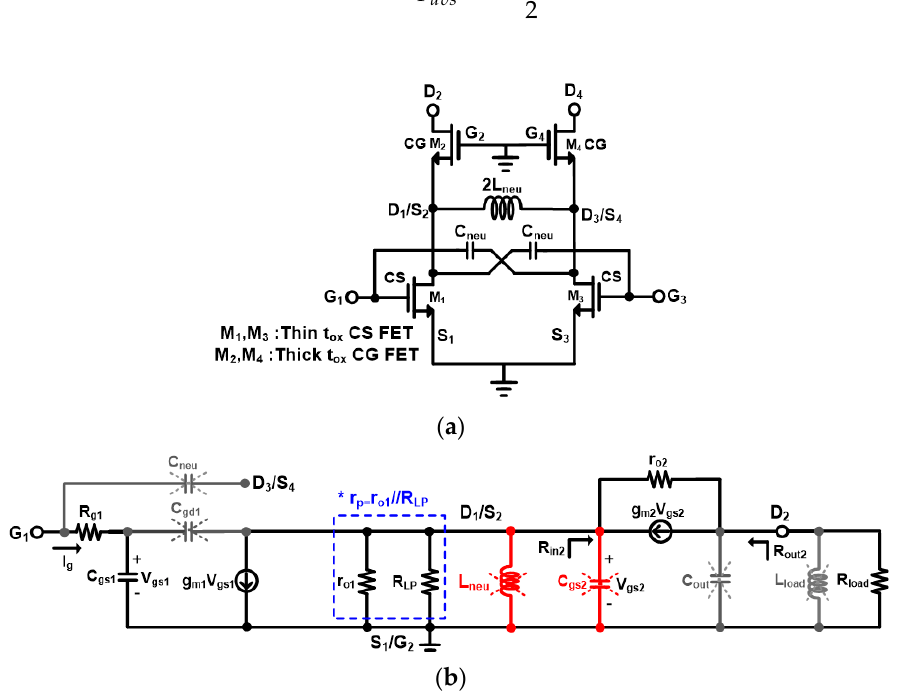
Figure 1. Hetero-stacked cascode power amplifier with a shunt inductor neutralization. The resistance R LP is a parallel equivalent resistance of the inductor L neu at the neutralizing frequency. ( a ) Simple differential hetero-stacked cascode cell schematic. ( b ) Small signal equivalent half